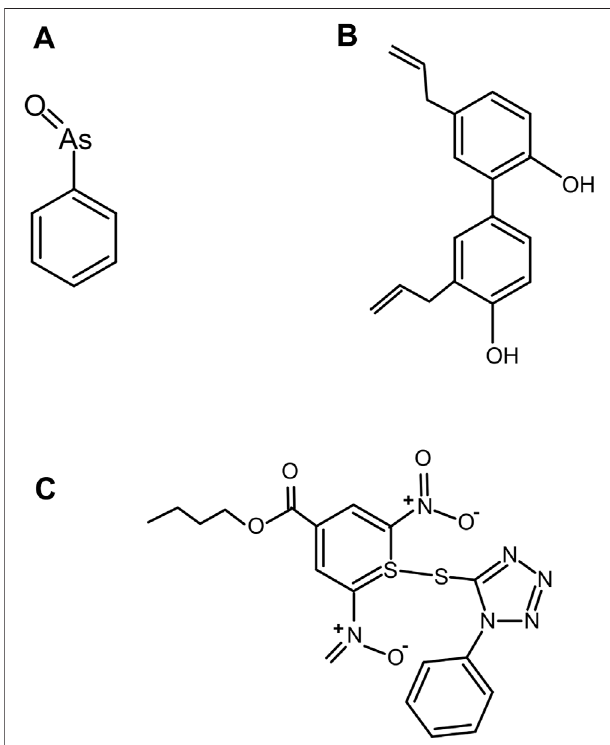
FIGURE 11 | Covalent inhibitor compounds. Structure of covalent inhibitor compounds: PhAs III (A) , an antagonist of Hh cholesterolysis; CID 72303 (B) , that can attenuate cholesterol-dependent Hh autoprocessing at micromolar concentrations as identi fi ed using HTS; and ST044643 (C) , Hh cholesterolysis inhibitor compound , reported to inactivate Hh covalently using (S N Ar) mechanism as identi fi ed using FRET-based